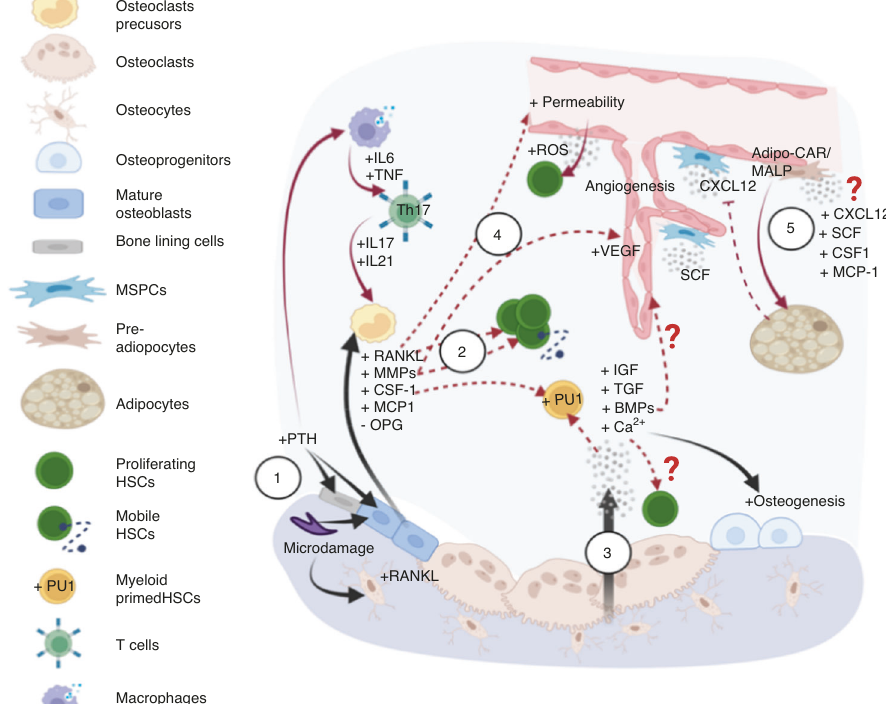
Fig. 1 Factors involved in the initiation of bone remodeling and their crosstalk with the hematopoietic compartment. (1) Homeostatic bone remodeling occurs in response to microdamage and systemic Ca 2 + needs. The nucleating event involves RANKL expression triggered